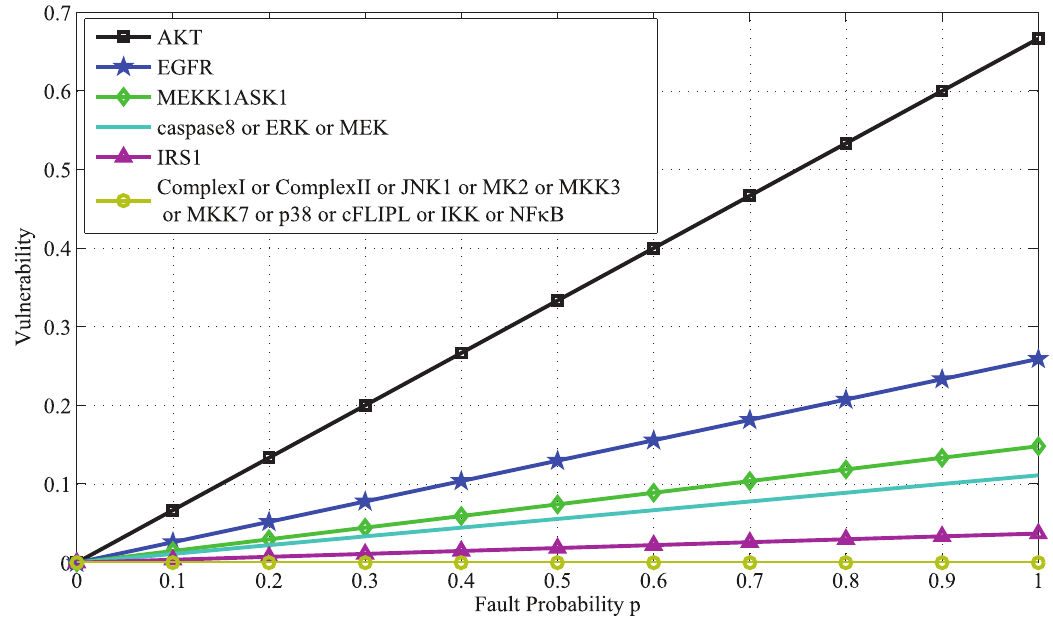
Figure 7. Vulnerability versus the fault probability p in the caspase3 network, copmuted using a ternary activity model. Upon considering three levels of activity for each molecule, active, partially active, and inactive, vulnerability of each molecule is graphed in terms of p . We observe that in the caspase3 network molecules are categorized into six groups, according to their vulnerability levels. Vulnerability is still the highest when AKT is faulty (black graph). EGFR vulnerability (blue) is higher than MEKK1ASK1 vulnerability (green). Vulnerabilities of the rest of the molecules are all below 0.1.